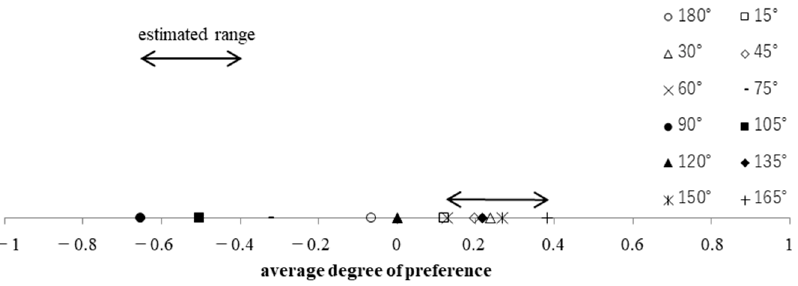
Figure 10. In terms of stripe angle conspicuity, angle 165° was the most conspicuous result. There was no significant difference in stripe angles of 165°, 150°, 30°, 135°, 45°, and 60°.